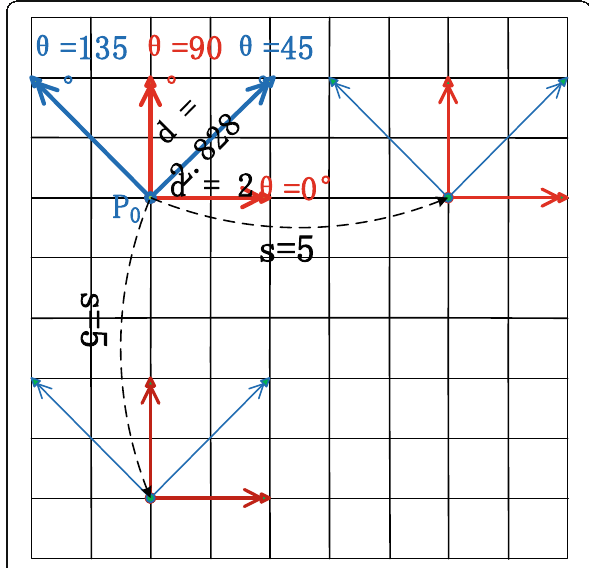
Fig. 3 Calculation of multi-scale gray level co-occurrence matrix where d represents displacement, θ is the angle, s is stride (or